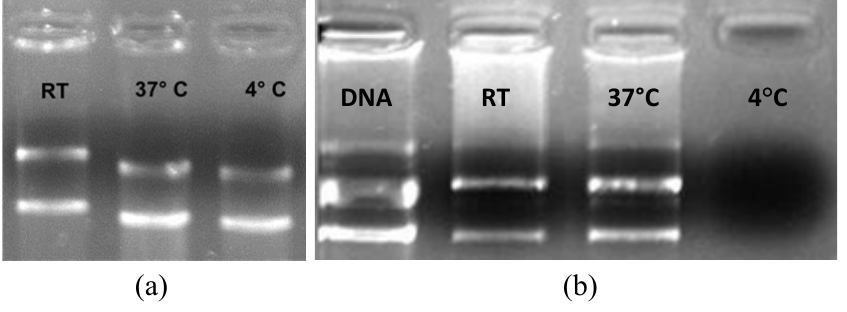
Figure 4. Influence of the environmental temperature on (a) naked pDNA (1 µg per well, with a total mass of pDNA of 1,000 ng) and (b) pDNA/CLN complex formation 1 (158.75 ng of pDNa per µL of CNL , with a total mass of pDNA of 1,270 1